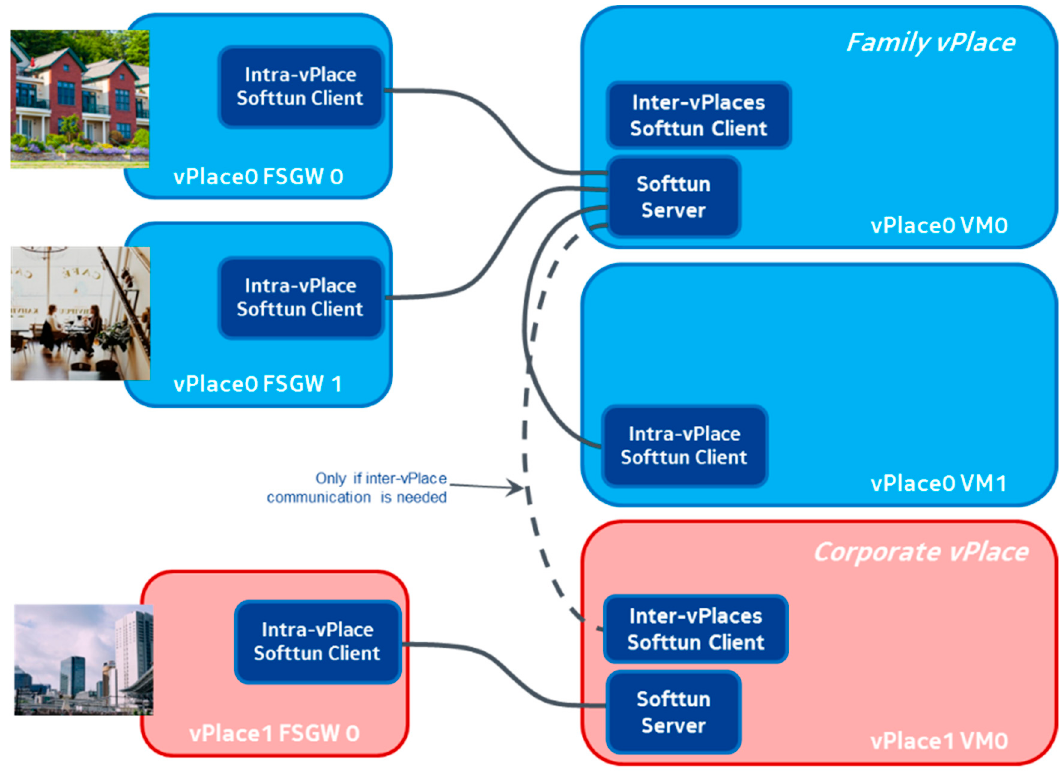
Figure 7. Ad-hoc Inter-vPlace tunneling.